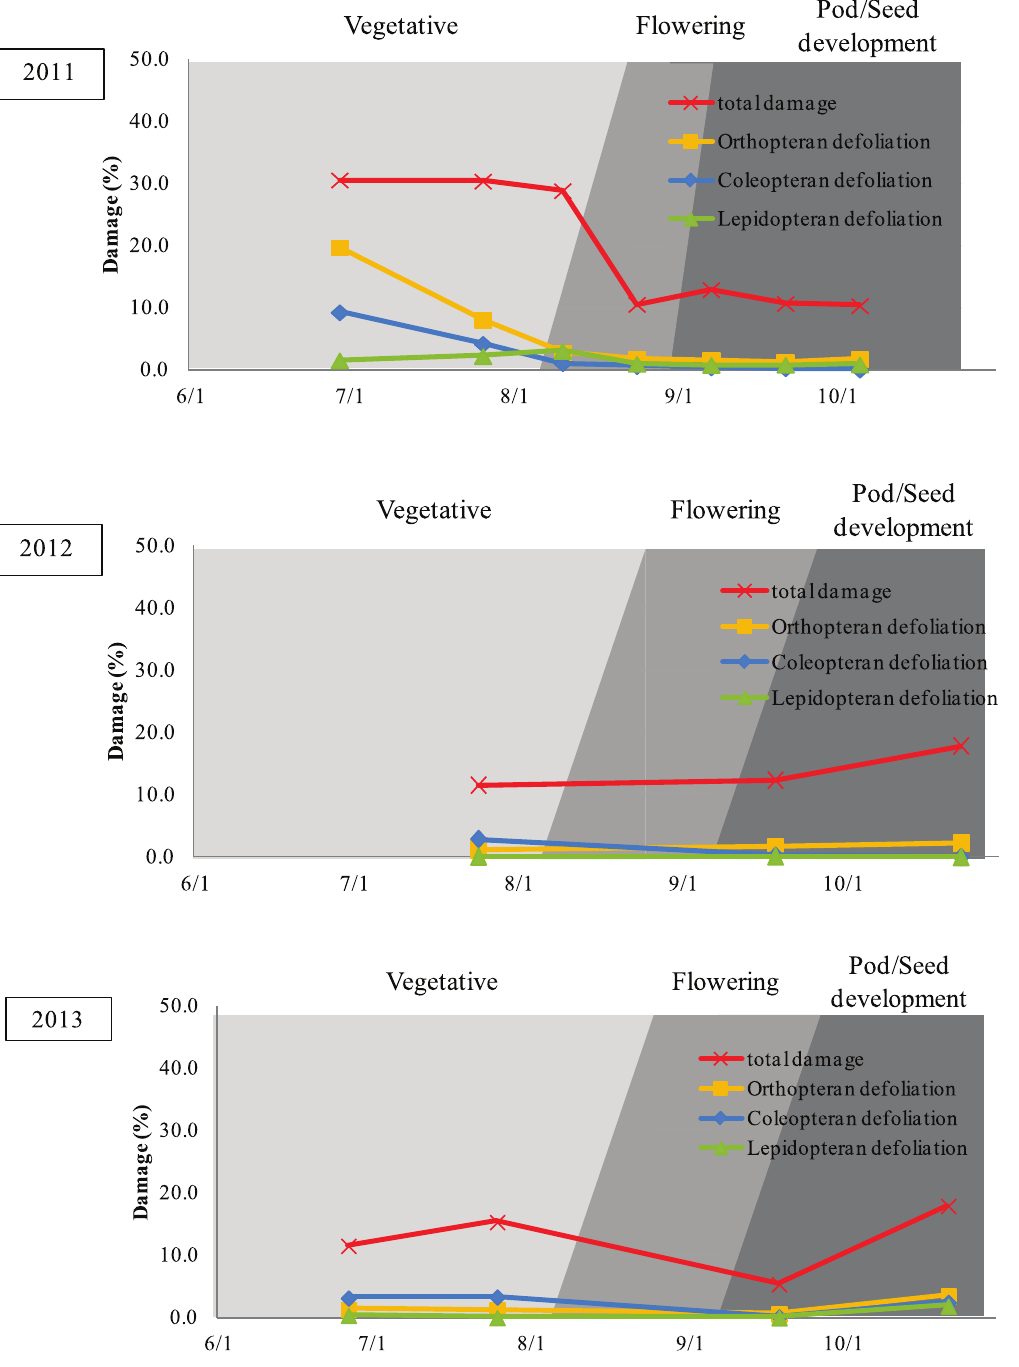
Fig 3. Observed level of defoliation by different insect taxa and the total insect damage by all organisms at Saga in in 2011, 2012 and